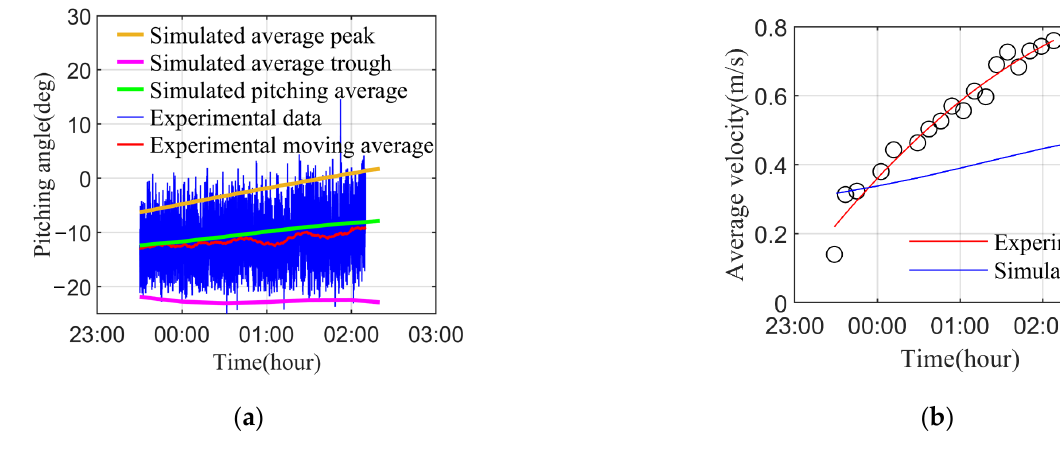
Figure 24. Numerical simulation results comparing with experimental data. ( a ) The simulated pitching angles comparing with experimental data; ( b ) the simulated longitudinal average velocities of the wave glider comparing with experimental data.